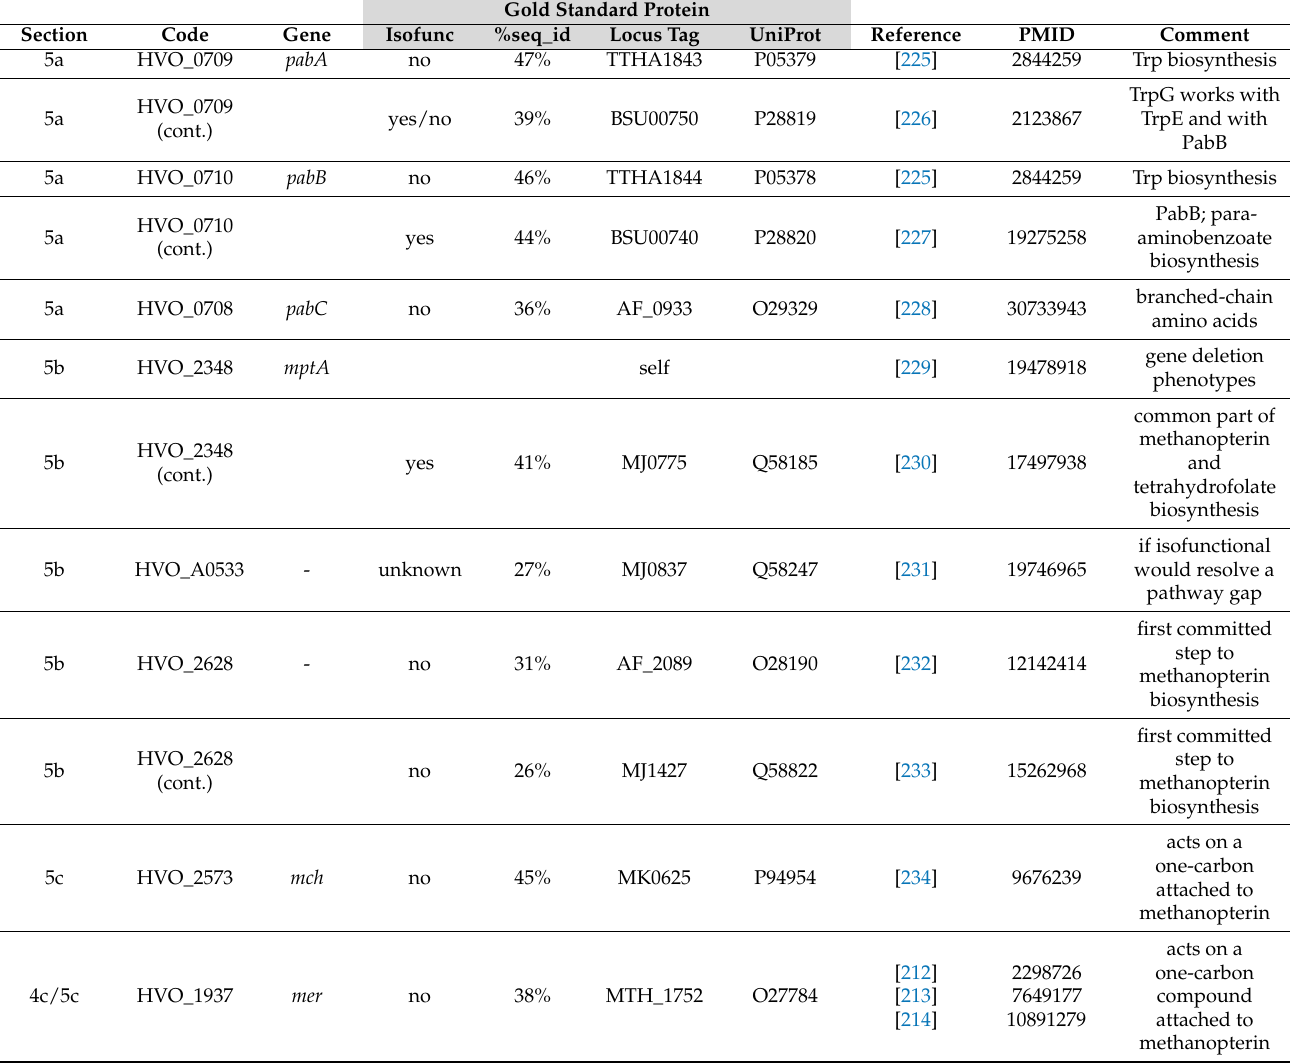
Table 5. Proteins with open annotation issues and their Gold Standard Protein homologs (Section 3.5). For a description of this table, see the legend to Table